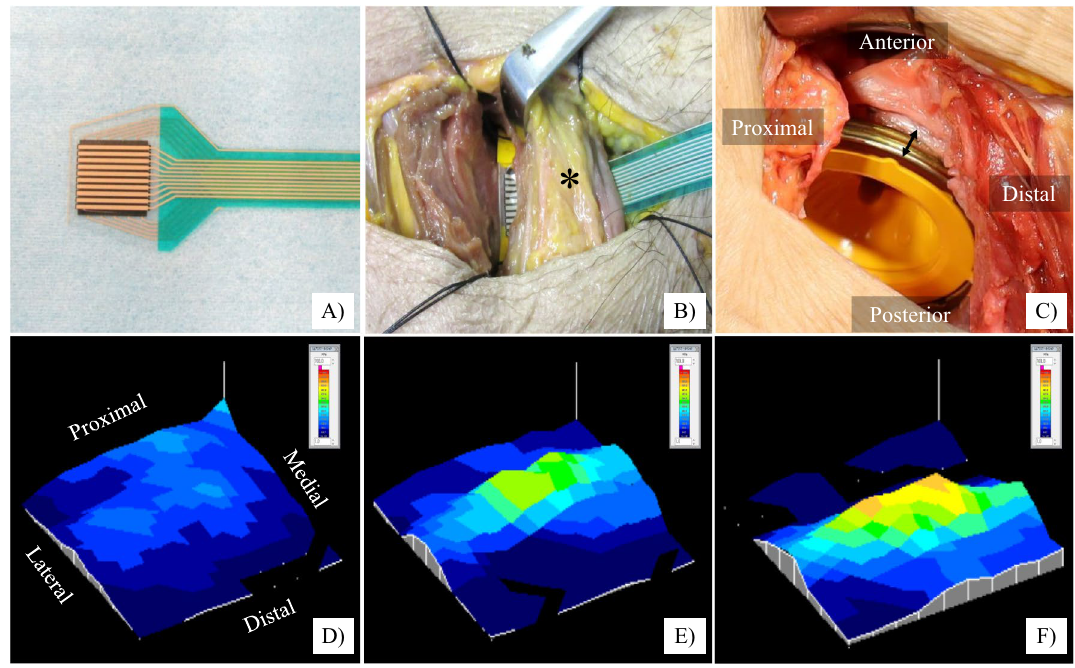
Figure 1. Photographs of the seat-type pressure sensor for real-time monitoring of the surface pressure of the iliopsoas muscle (I-SCAN, Nitta, Osaka, Japan). ( A ) The sensor is 0.1 mm thick with dimensions of 10 × 10 mm. ( B ) The pressure sensor was placed between the iliopsoas muscle and anterior cup edge via an ilioinguinal approach. ( C ) Photograph showing the condition of the anterior cup protrusion length. ( D – F ) A typical case of the maximum surface pressure of the iliopsoas muscle with the hip in 20° of extension. Anterior cup protrusion length: ( D ) 0 mm, ( E ) 3 mm, ( F ) 6